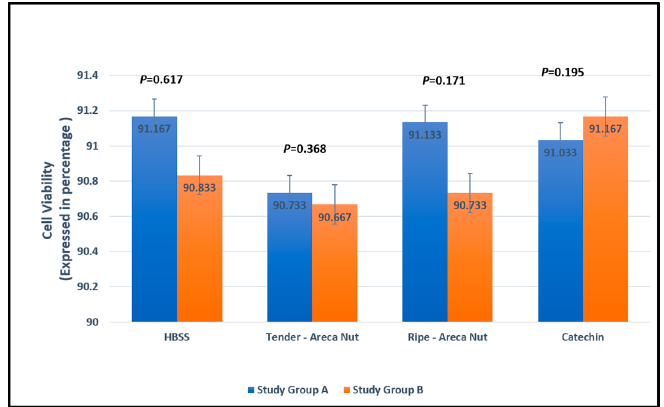
Figure 2. Intergroup comparative analysis of cellular viability of cPMNs.